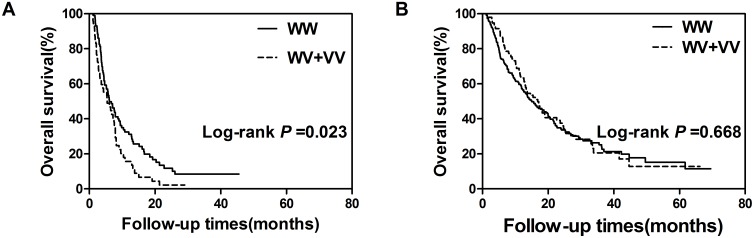
Kaplan-Meier plots of overall survival in patients without PVTT (A) and in patients with PVTT (B).